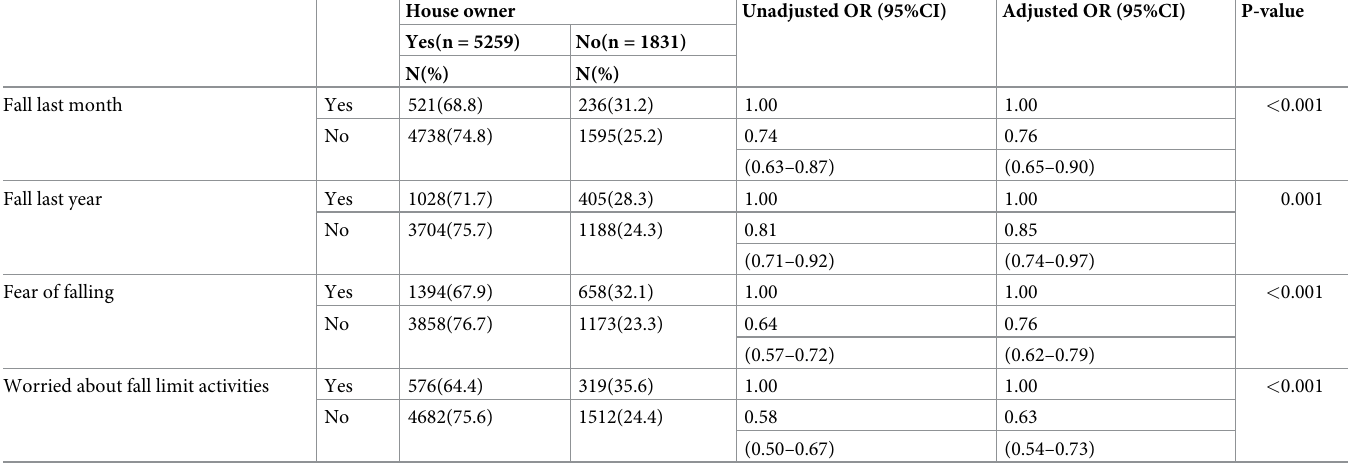
Table 2 presents the results of the bivariate statistical analyses of fall-related outcomes and house ownership. The relationship between fall last month and FOF/worried about fall-limited activities and house ownership was statistically significant (P < 0.001). Multiple logistic regression analysis was conducted to analyze the association between fall- related outcomes and house ownership. Compared to older adults who owned their own Table 2. Univariate analysis on the association between fall-related outcomes and house owner (n = 7,090). House